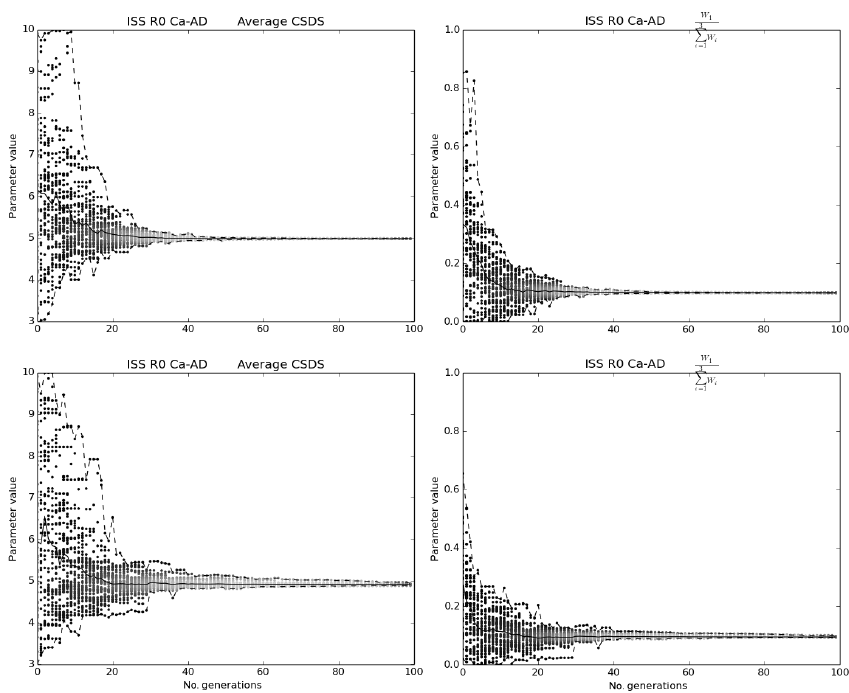
Figure 6. Parameter evolution plots (left: average CSDS; right: illite content) for the noisy patterns of assemblage 1 for the multi-specimen run (top plots) and the isolated AD run (bottom plots). Minimum and maximum values during the refinement are indicated with dashed lines, iterations’ best solutions at each generation indicated by dots and average solution with a solid line. The higher the density of the dots, the lighter they are